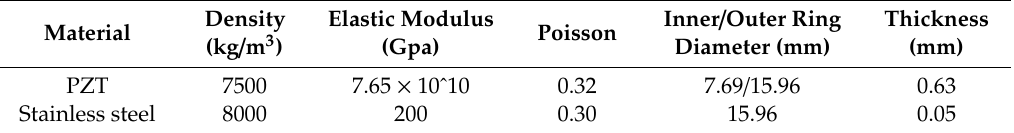
Table 1. Material and geometric parameters of the piezoceramic vibrating mesh atomizer.